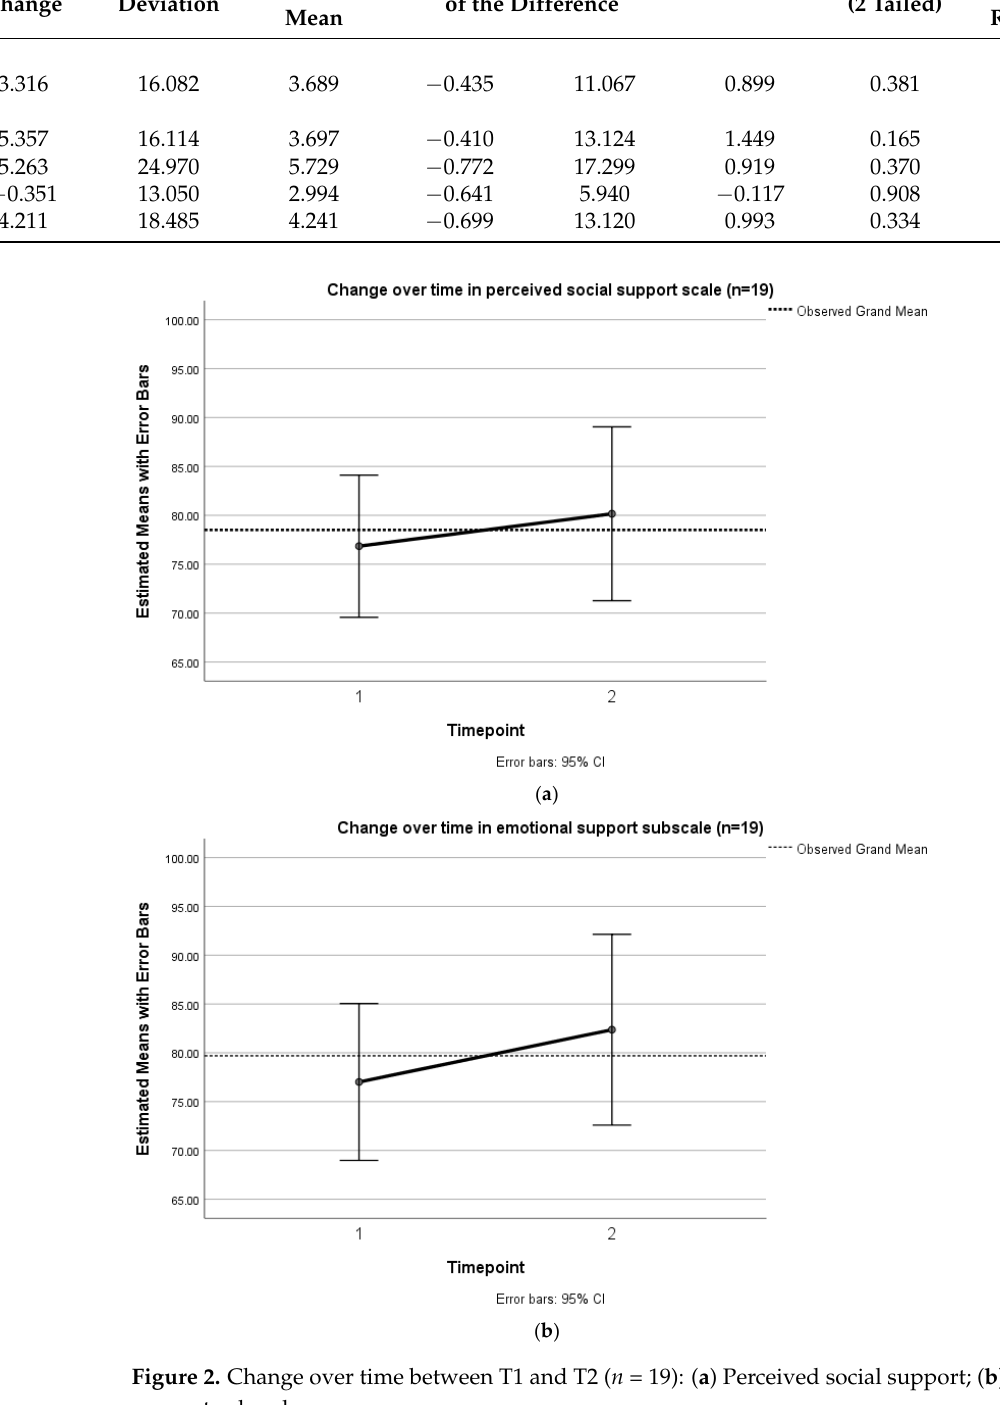
Figure 2. Change over time between T1 and T2 ( n = 19): ( a ) Perceived social support; ( b ) Emotional support